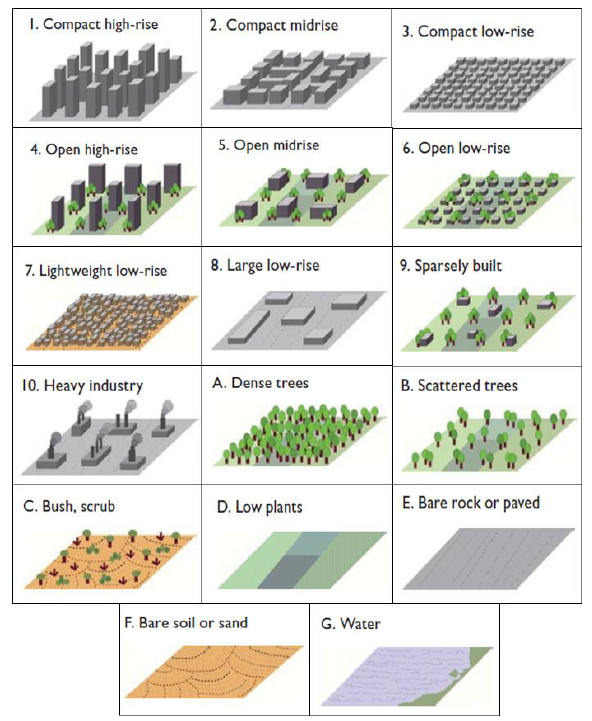
Figure 1. Local Climate Zones scheme: Built-types (1-10),